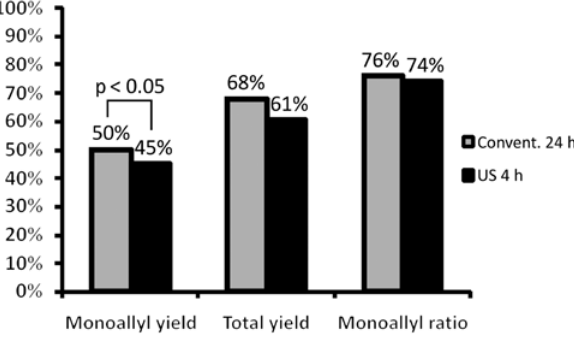
Figure 4: Comparison between the conventional 24-h reaction and US-based 4-h